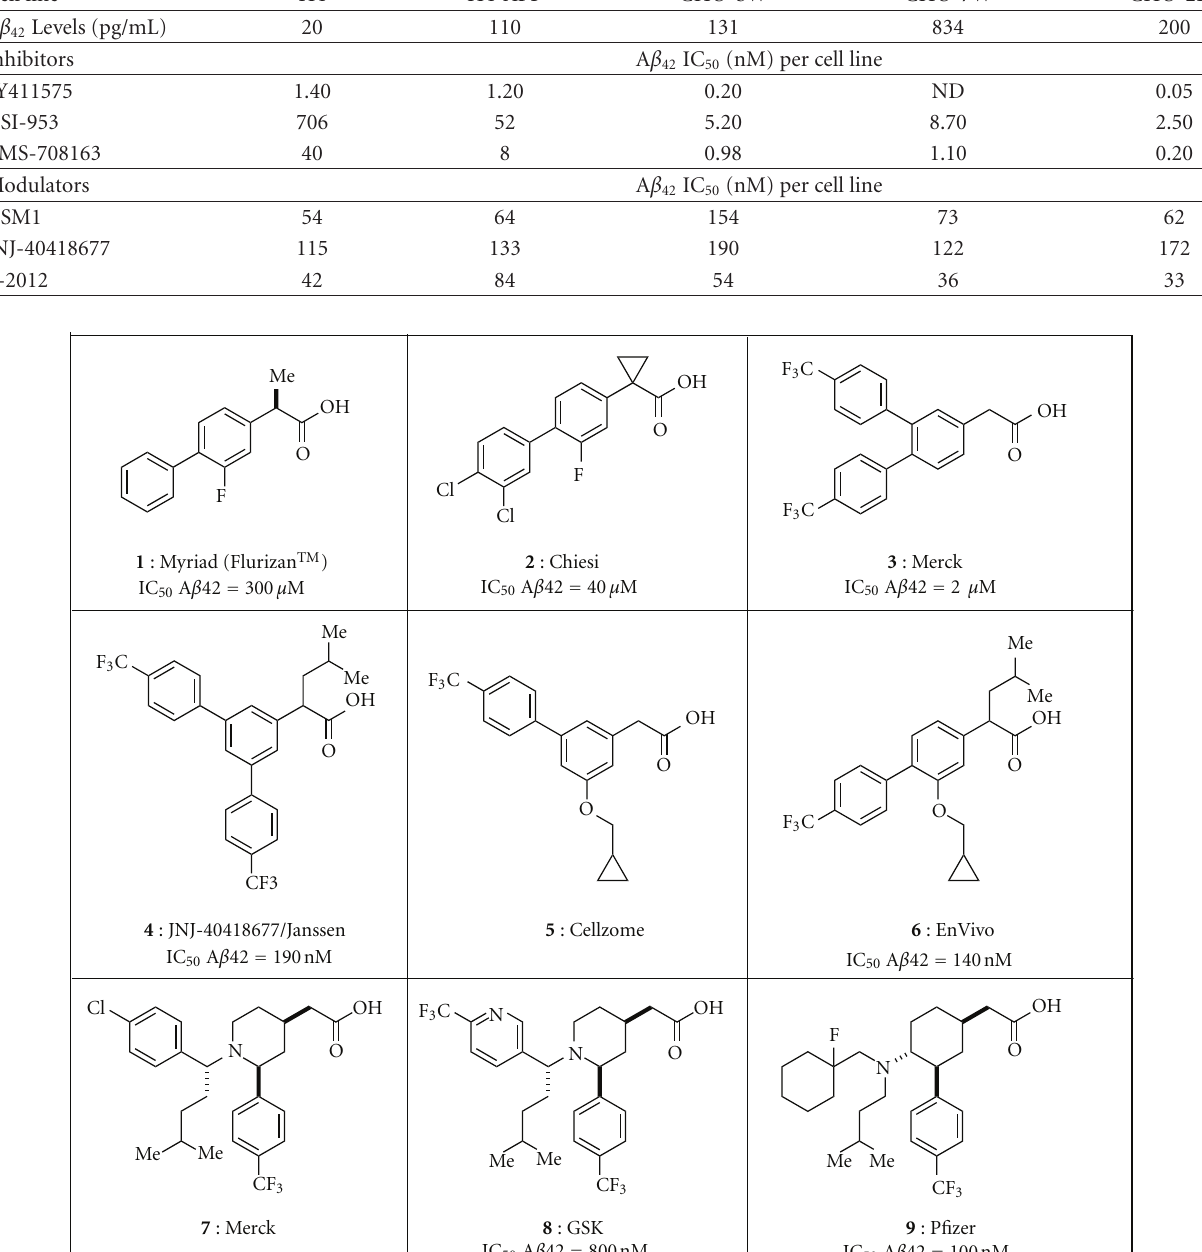
Table 1: GSMs do not show a potency shift with APP overexpression.